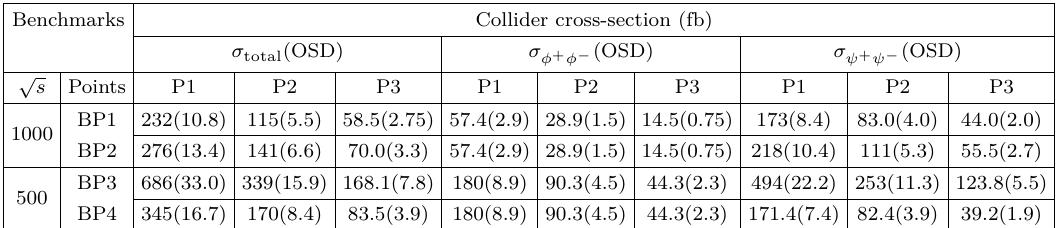
Table 3. Signal cross-sections for HDSP pair production (OSD final state) at ILC. Total cross- section ( σ ), as well as individual contributions from SDM ( σ tolal mentioned. Three choices of beam polarisation are used: P1 ≡ { P